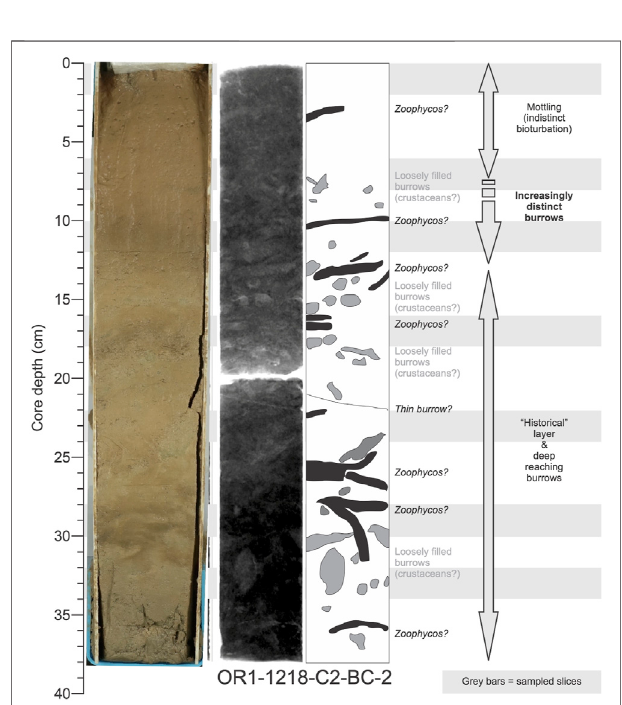
FIGURE 5 | Assessment of the vertical extent ofsediment mixing aswell as the intensity by visually analyzing photograph and radiograph images from sub-core 2exemplarily. All images are in the Supplementary Figure S1 . The radiograph image was done on a thin slab (~1 cm thick sediment slice). Possible burrowing activities are indicated on the radiograph image for Zoophycos (black) and loosely fi lled burrows (gray). The characteristic depth intervals of bioturbated sediments are described as well. Horizontal gray bars indicate the sampled layers for 14 C analyses.